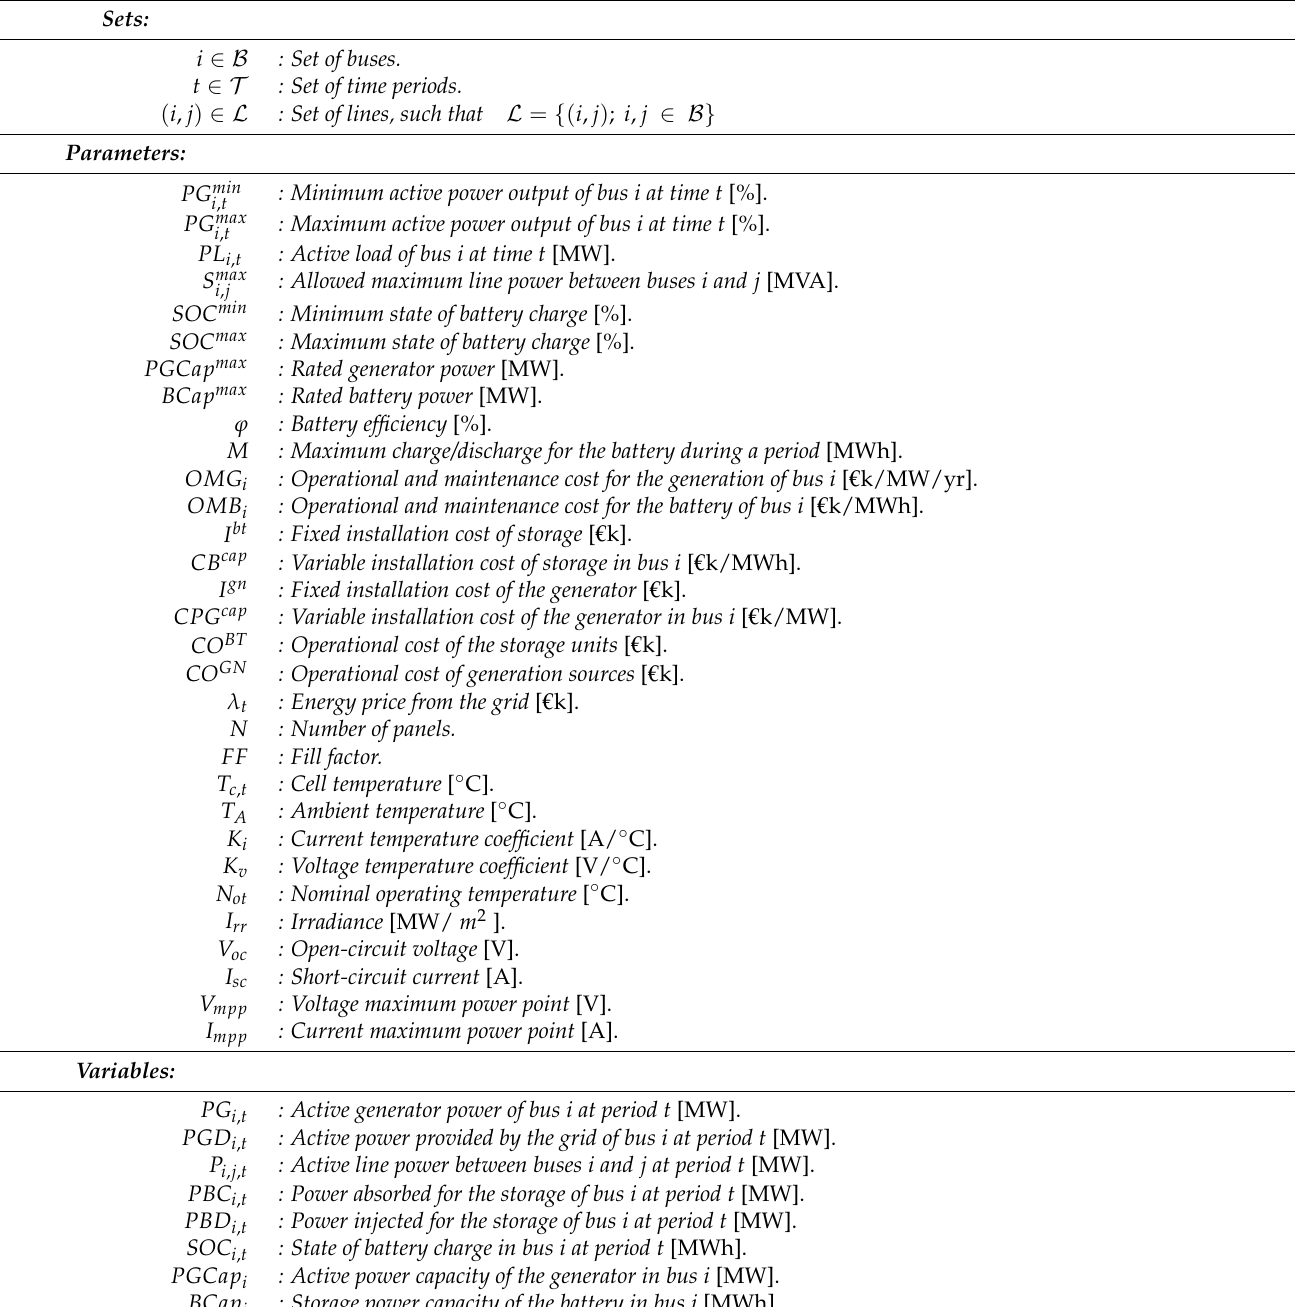
Table 1. Sets, parameters, and